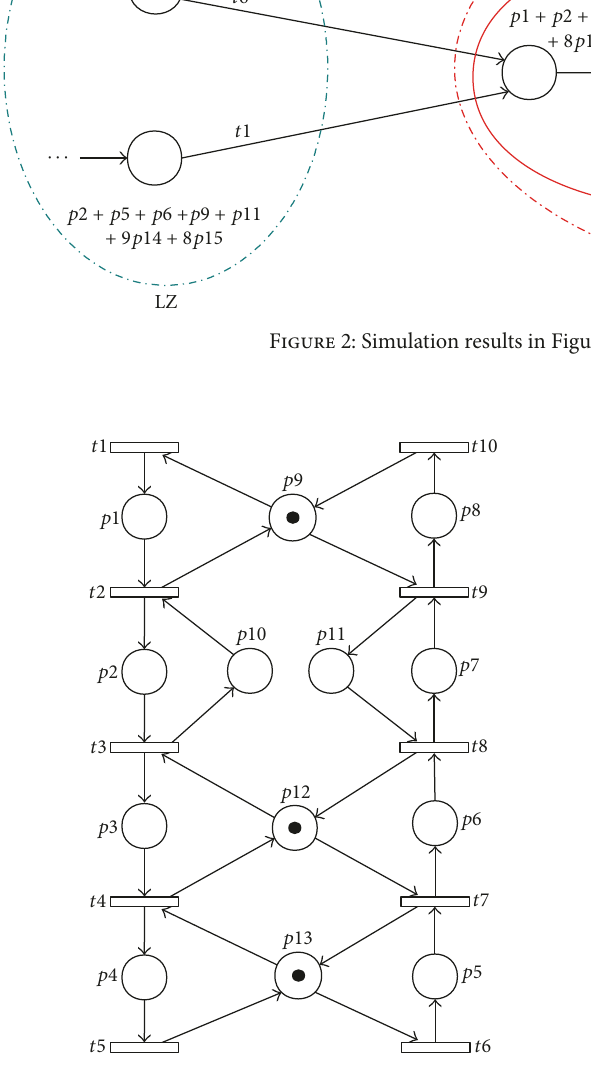
Figure 3: A simplified S 3 PR model based on Figure